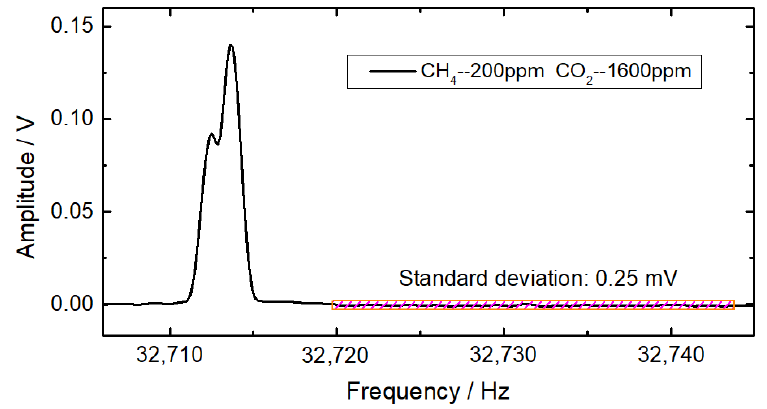
Figure 8. Evaluation of detection limits.